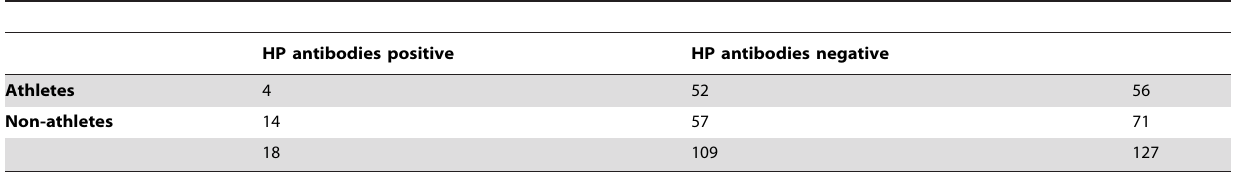
Table 3. The distribution of the study population related to Helicobacter pylori (HP) antibodies and if the subjects are athletes or non-athletes.